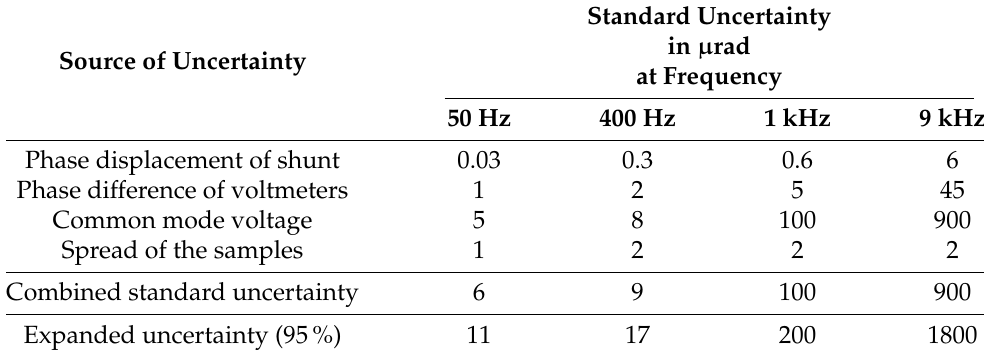
Table 5. Uncertainty of the displacement angle without a custom-designed Wagner earth